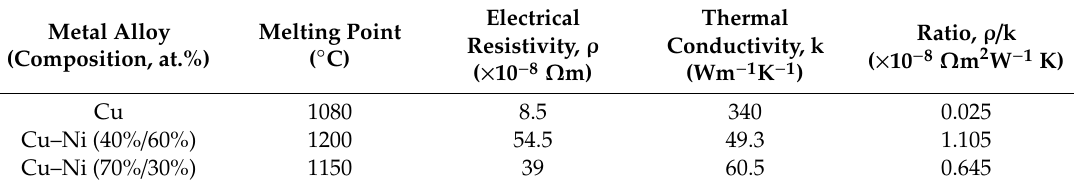
Table 1. Comparison between material properties of Cu and relevant Cu–Ni alloys [45,46]. Metal Alloy (Composition,